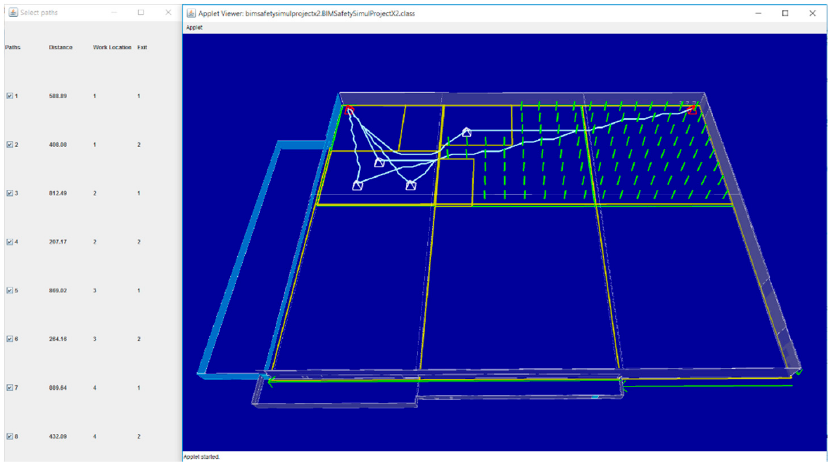
Figure 13. All evacuation paths found from scenario 1.